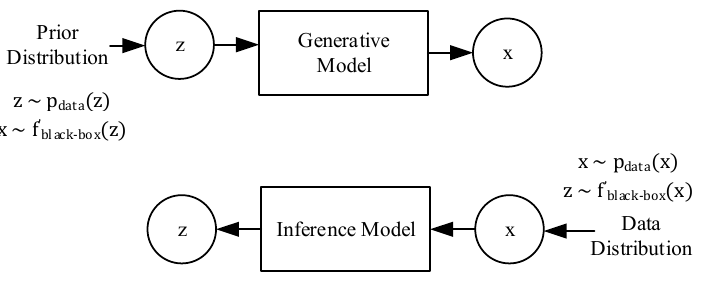
Figure 1. Generative and inference modeling similarities.